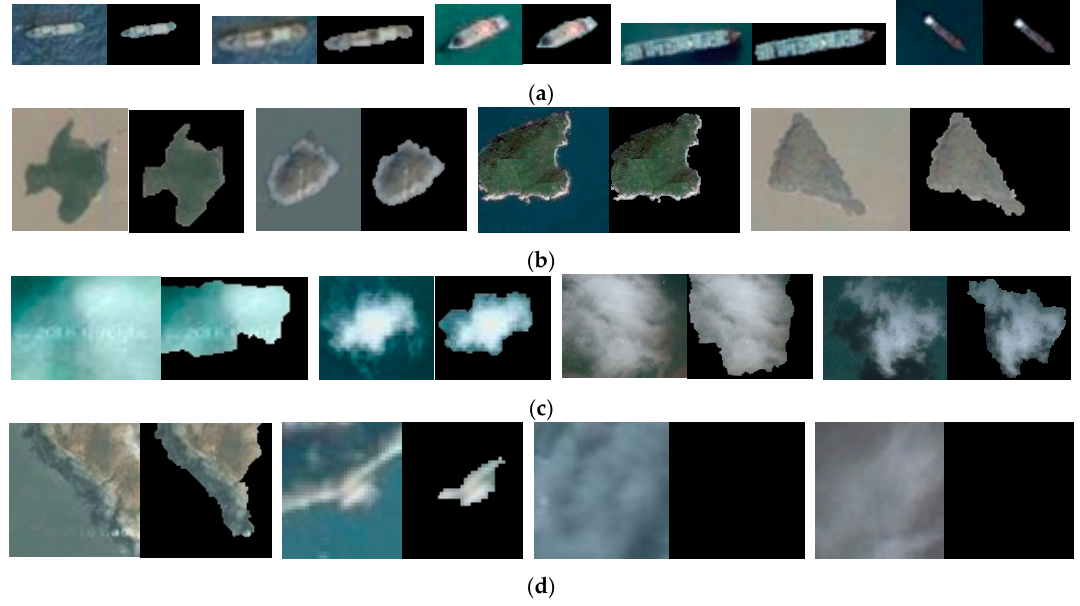
Figure 8. Some fine segmentation results: ( a ) ship chips; ( b ) island chips; ( c ) cloud chips; ( d ) other chips.